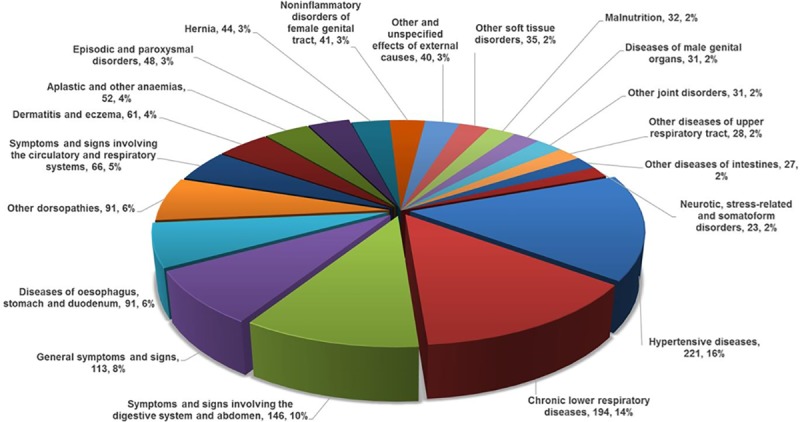
Twenty most common forms of non-communicable disease–ICD 10 coding (1,415 Cases).